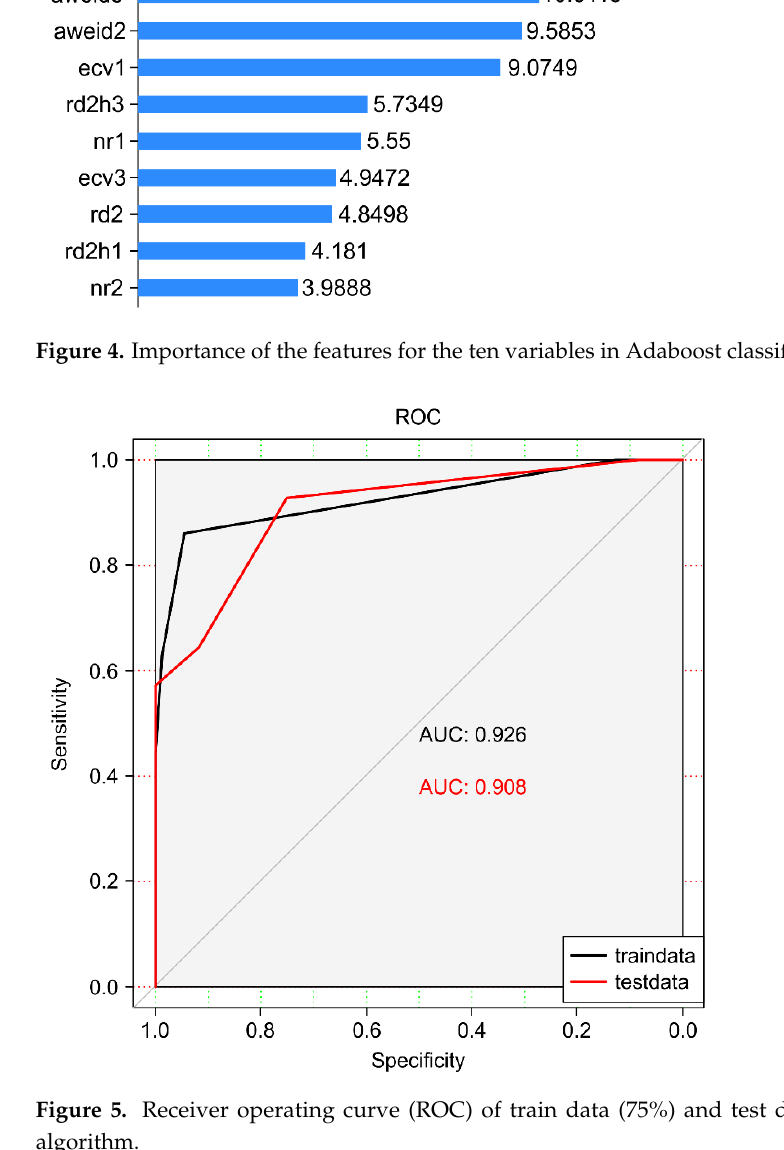
Figure 5. Receiver operating curve (ROC) of train data (75%) and test data (25%) of the Rpart algo- rithm.